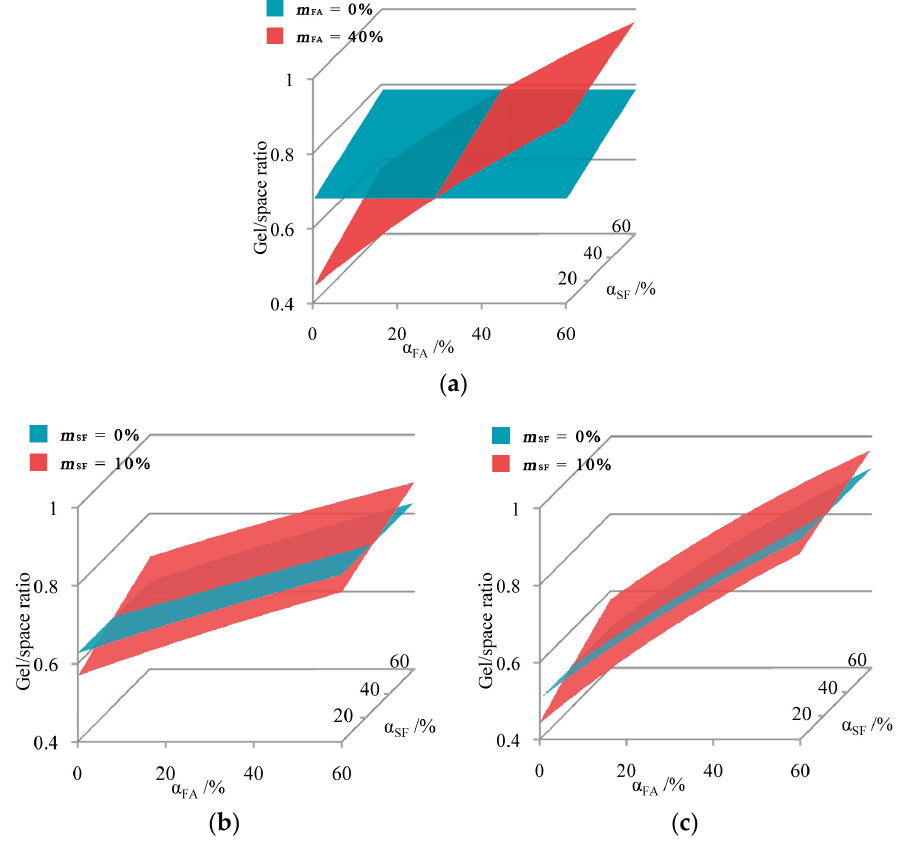
Figure 9. Relationship between gel/space ratio and reaction degrees in the C-SF-FA system: ( a ) FA replacement, when m SF = 10%; ( b ) SF replacement, when m FA = 20%; and ( c ) SF replacement, when m FA = 40%.